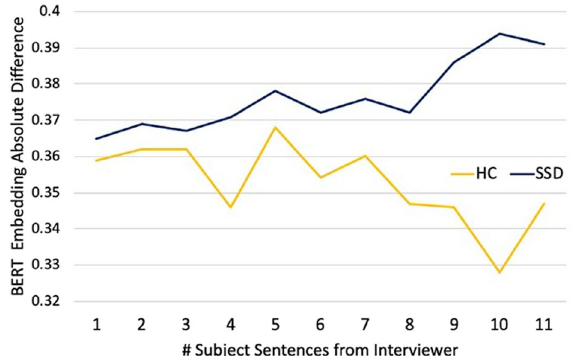
Fig. 2 Sentence embedding distance by interviewer-participant exchanges. The average BERT sentence embedding difference between the original interviewer prompt and the participant ’ s response sentence, varying by distance from the original prompt. Responses from individuals with SSD began signi fi cantly farther from interviewer prompts relative to HC and traveled increasingly father away where those of HC did not. Fitting linear regressions to the trajectories, we fi nd: SSD intercept = 0.260, 95% CI [0.257, 0.263]; The analysis was repeated excluding the 3 SSD outliers with high TLC scores and the results were